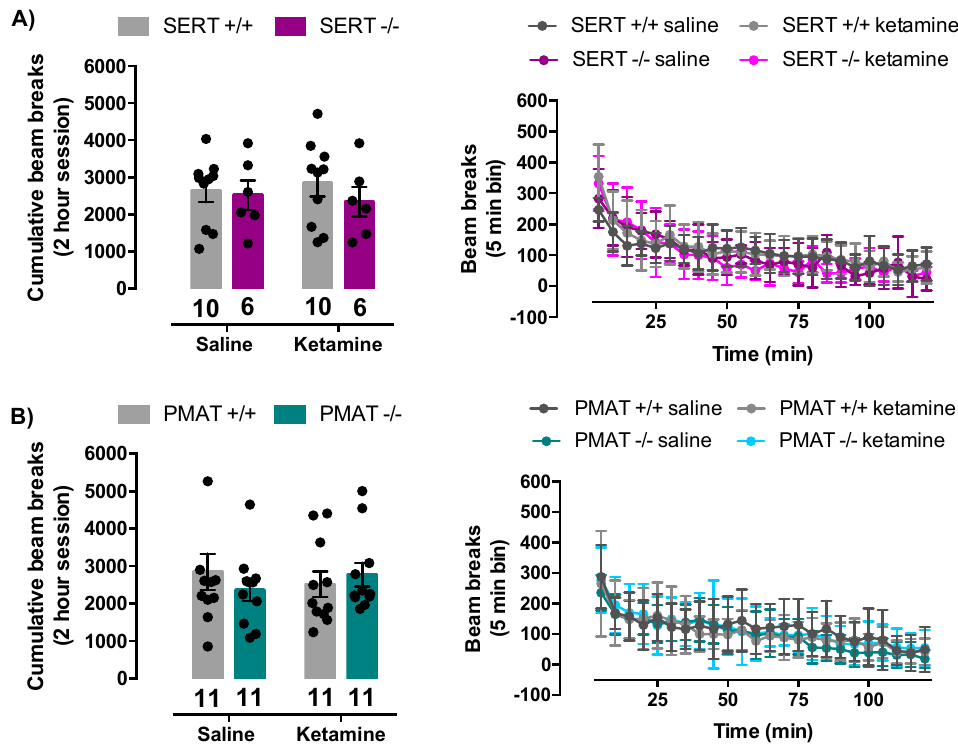
Figure 6. Ketamine did not significantly impact locomotor activity of SERT +/+ , SERT − / − , PMAT +/+ , or PMAT − / − mice. ( A ) There was no significant di ff erence in locomotor activity of SERT +/+ and SERT − / − , or ( B ) PMAT +/+ and PMAT − / − mice, when given ketamine or saline. Bar graphs show total number of beam breaks in the two-hour recording period. Panels on the right show beam breaks in 5 min bins as a function of time. Circles represent individual mice. Data are mean ± S.E.M.